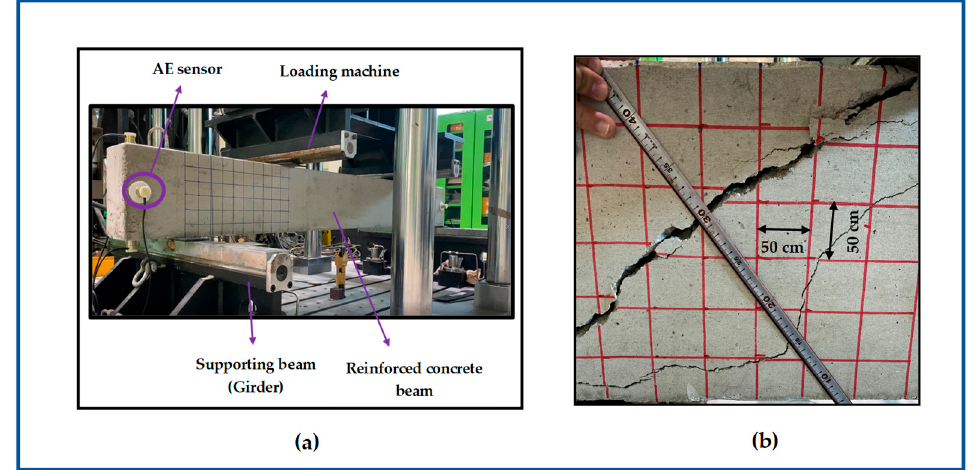
Figure 5. The real-time experimental testbed for the reinforced concrete (RC) beam: ( a ) the entire setup and ( b ) measurement of the cracks.